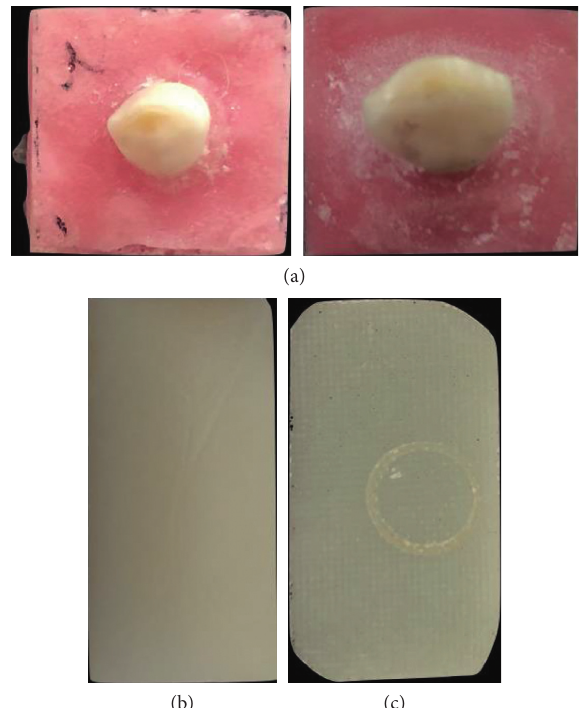
Figure 1: (a) Primary canine mounted, (b) zirconia crown material disc, and (c) glass-fiber-reinforced composite crowns crown ma- terial